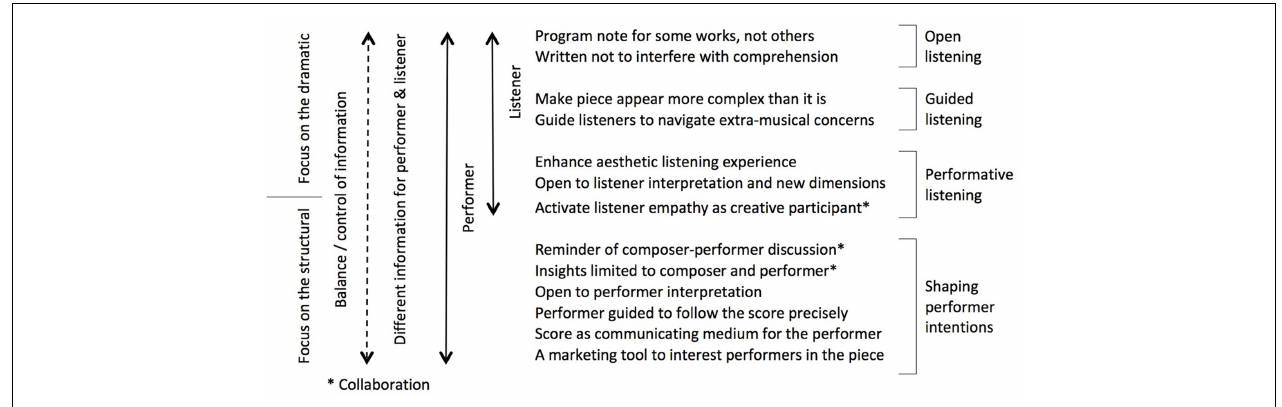
FIGURE 3 | Composer-written program notes: recipient, information type, and intended